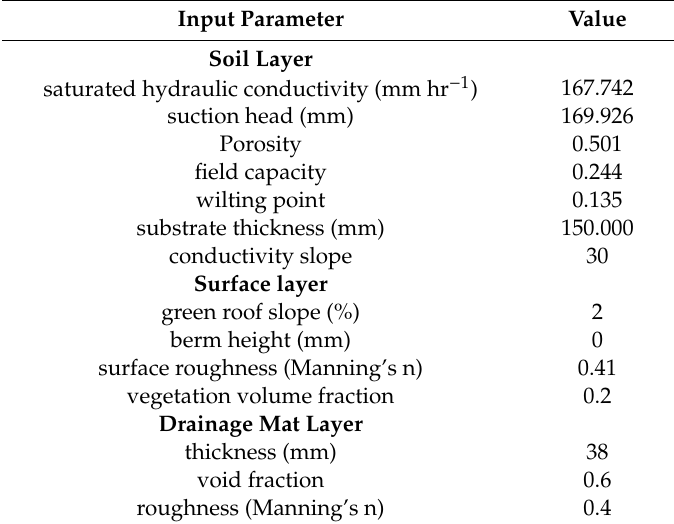
Table 5. Physical input parameters for the Storm Water Management Model (SWMM) modeled GRS.